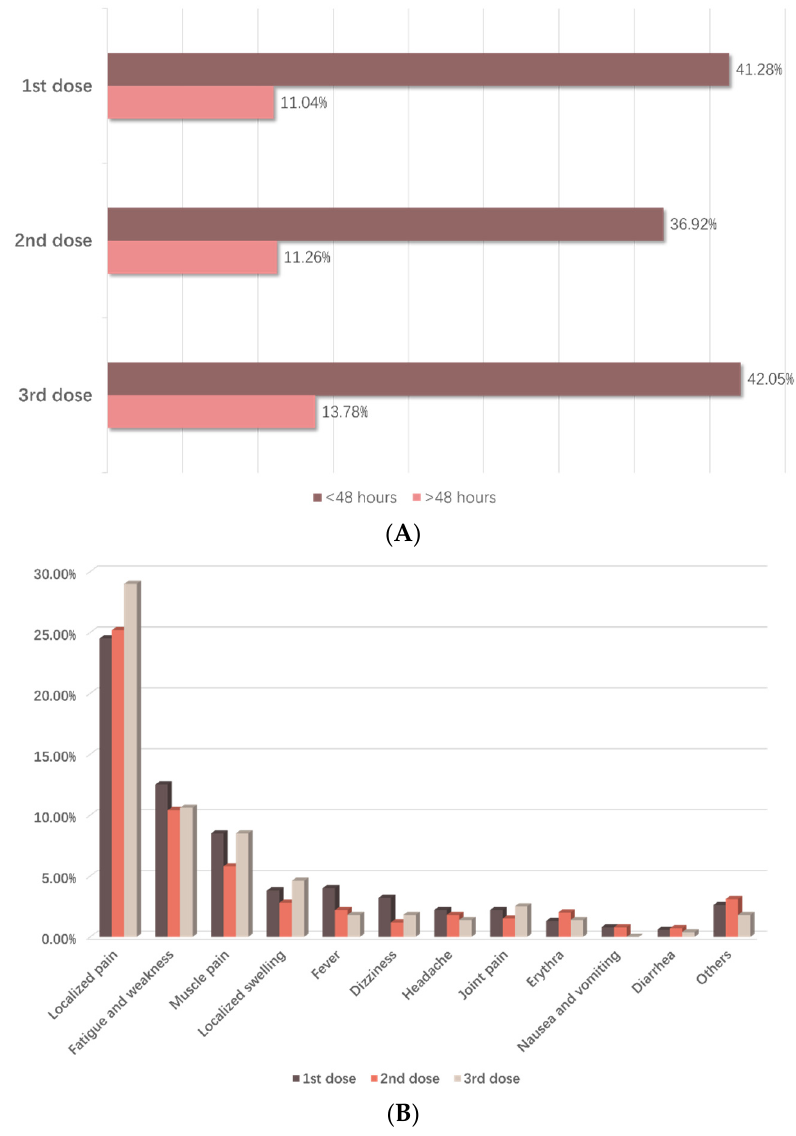
Figure 1. Self-reported Adverse Events among Vaccinated Patients. ( A ) Incidence of adverse events within and after 48 h for each dose. ( B ) Incidence of specific adverse events within 48 h for each dose in reported